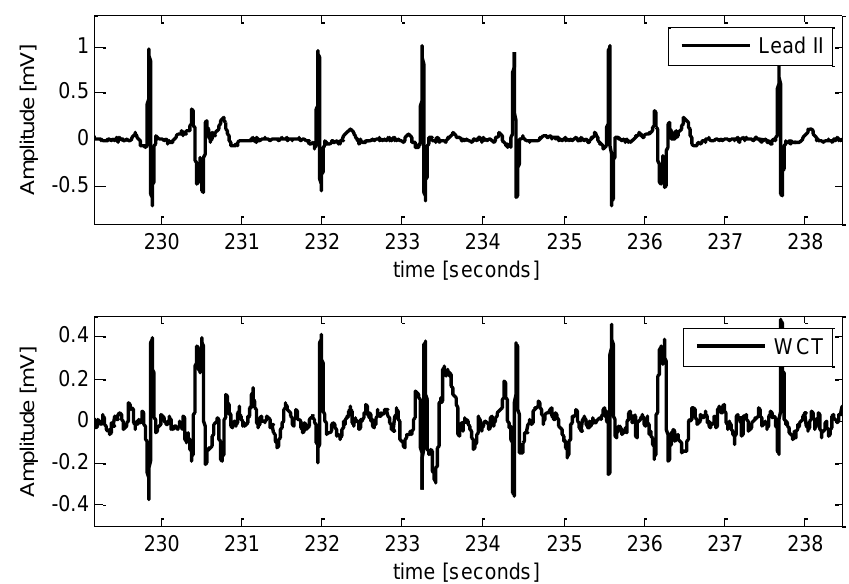
Figure 6. Example of multimodal WCT with severe alteration during ectopic beats (noted with a black arrow). WCT is 45% of lead II amplitude (average); recording is from a 72-year-old female patient admitted from the emergency department with severe chest pain.